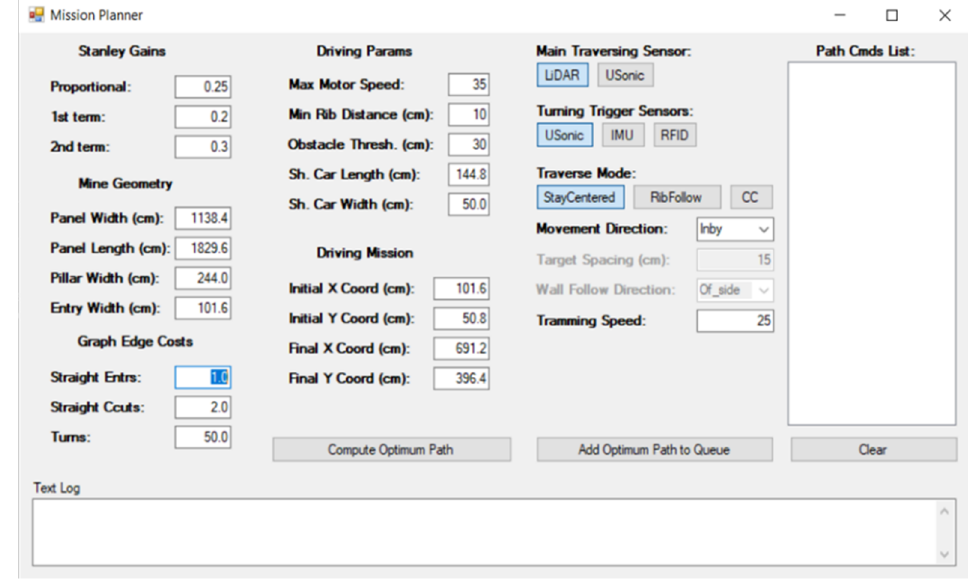
Figure 9. Mission planner form.